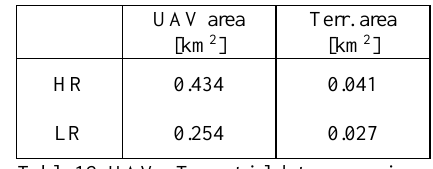
Table 12. UAV - Terrestrial data comparison.